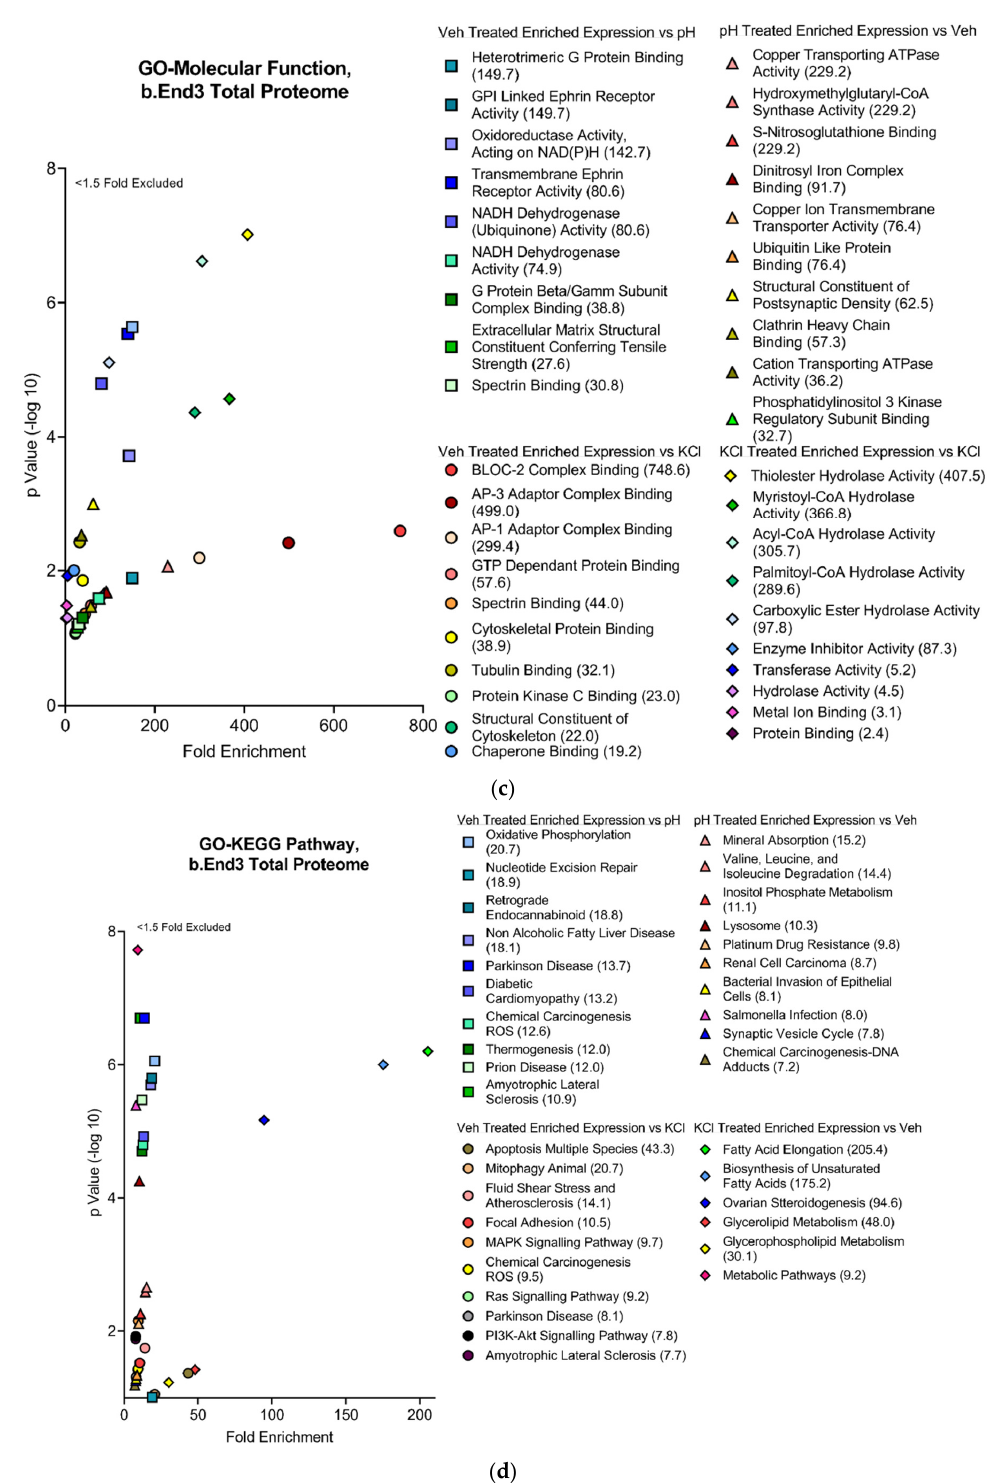
Figure 5. Global proteome significantly enriched proteins separated by treatment group and visu- alized with fold enrichment vs. − log10 transformed p -value scatterplots. Top ten cellular processes and pathways by total fold enrichment for the three GO databases ( a ) BP, ( b ) CC, ( c ) MF, and ( d ) KEGG pathway databases represented by individual plots demonstrate upstream convergence of changes in total protein enrichment of cell processes and pathways involved in maintenance of cell structural homeostasis. n = 4 per treatment